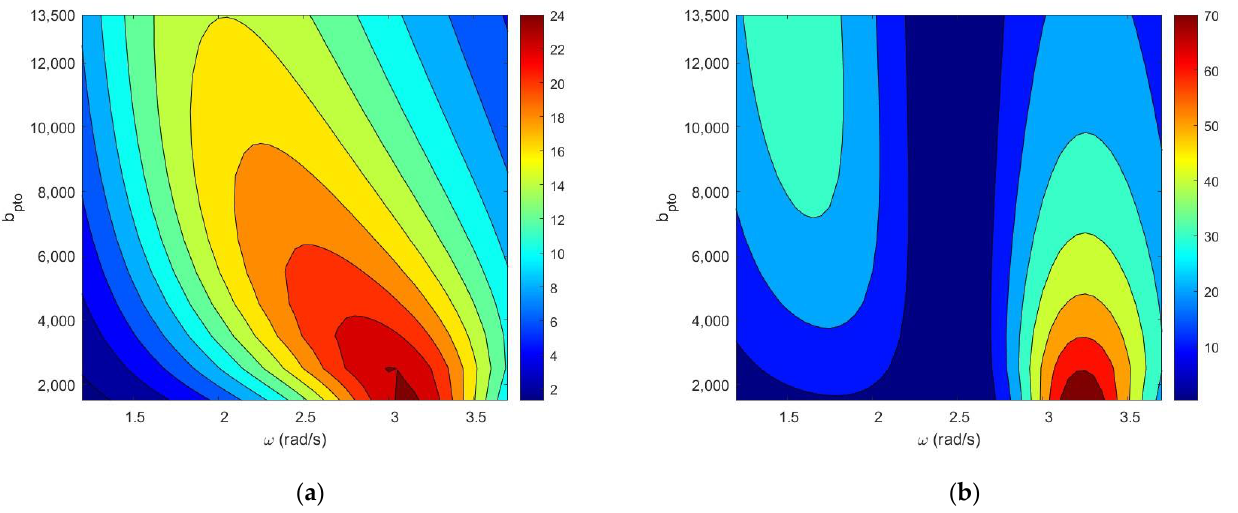
Figure 19. CWR of the WEC with various PTO damping coefficients: ( a ) without a breakwater; ( b ) with a breakwater (Case 1).